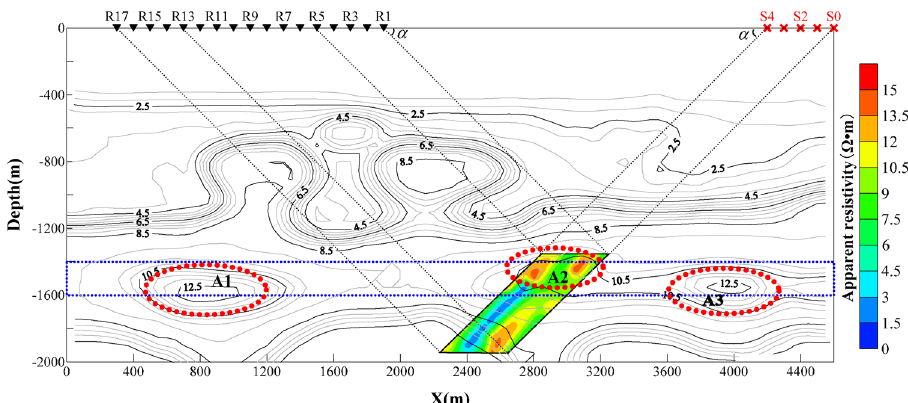
Fig. 9 Geometry imaged appar- ent resistivity profile (in color) of MCSEM compared with the result of 2-D TEM inversion (the